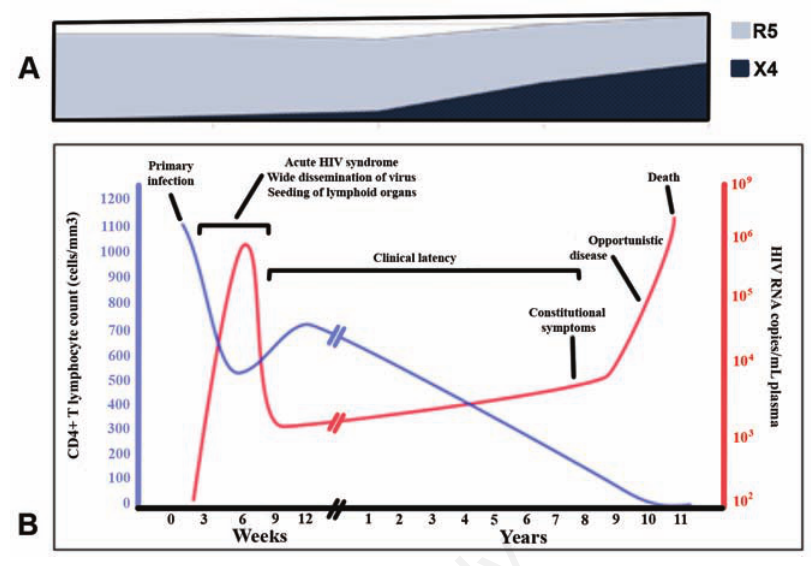
Figure 1. Role of R5 and X4 HIV strains in disease progression. A) Persistence R5 HIV-1 strains at all stages of HIV infection particularly at the late stages of HIV infection where- as X4 HIV-1 strains emerge at the advanced disease stage only; B) the course of HIV infec- tion and disease. Levels of CD4 and viral load are shown to correlate with the progress of HIV infection and CD4+ T cell depletion.